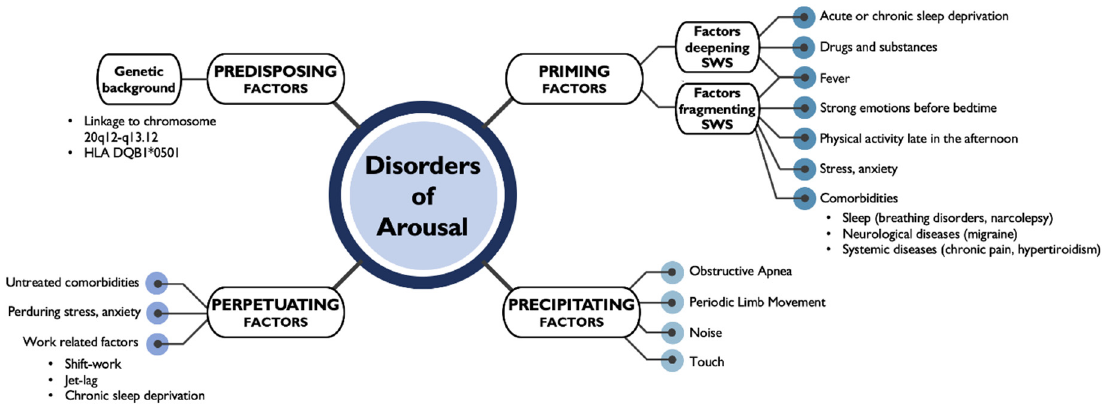
Figure 1. The 4-Ps model of factors involved in DoA pathophysiology. On a predisposed genetic background, different priming factors could lead to the occurrence of DoA episodes, possibly provoked by additional precipitating factors. The persistence of unresolved causes may lead to the perpetuation of DoA in adulthood and even in the elderly. HLA, Human Leukocyte Antigen; SWS, Slow Wave Sleep.